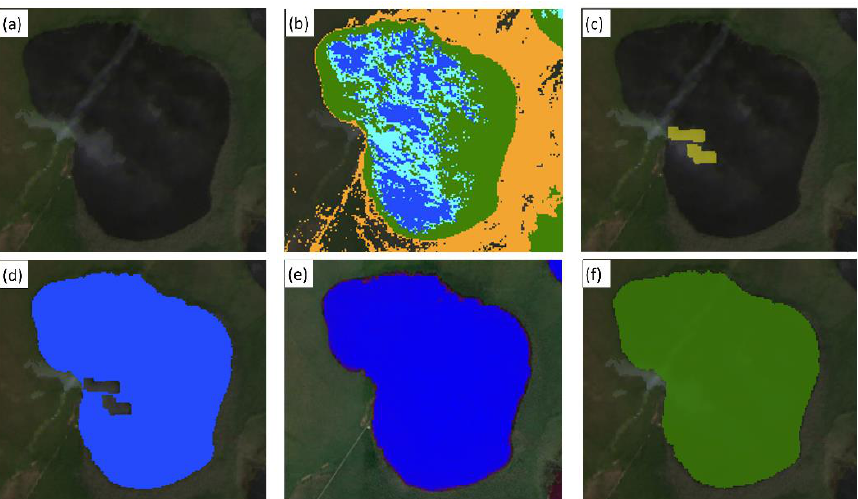
Figure 4. Representation of our surface area classifications over Great Lake in Eastern North Carolina taken on 19 January 2017: ( a ) Landsat satellite image; ( b ) DSWE classifications with high probability of water (blue), moderate probability of water (cyan), low probability of water (orange), inundated vegetation or wetland (green), no water (no color); ( c ) cloud mask; ( d ) initial water mask; ( e ) Pekel surface water occurrence values ranging from low occurrence (red) to high occurrence (dark blue); ( f ) complete water mask with cloudy areas filled in.